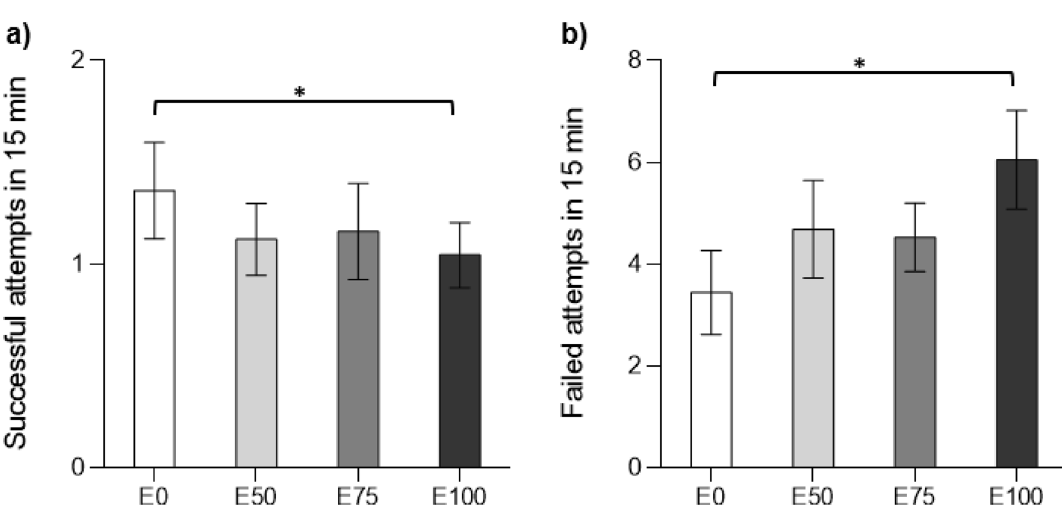
Figure 4. Foraging measures. Mean ± SE ( a ) number of zooplanktons eaten in 15 min, ( b ) number of failed attempts for damselfly larvae exposed to 0, 50, 75, and 100% effluent (E0, E50, E75, and E100, respectively). Statistically significant differences between control and exposed treatments after exposure are indicated with an asterisk (*p <